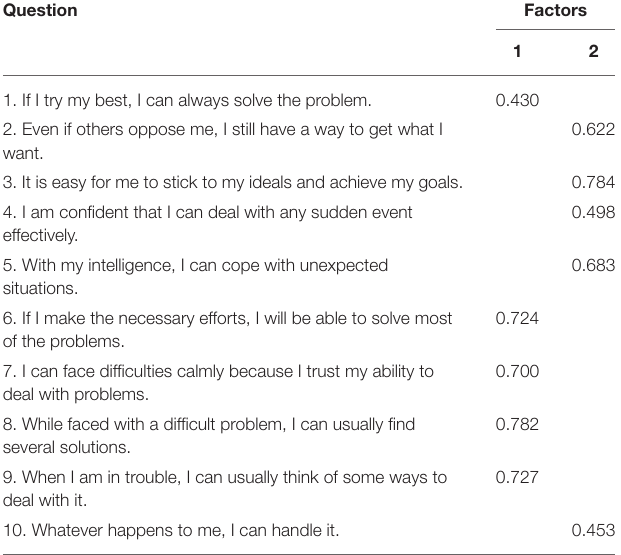
TABLE 2 | Factor analysis of self-efficacy of children in